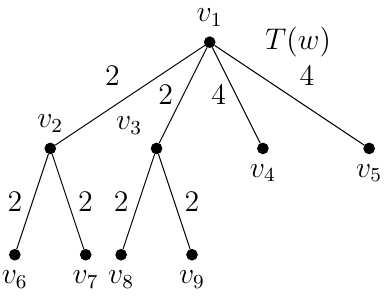
Figure 12: T ( r, w ) is equidistant if and only if r ∈ { v